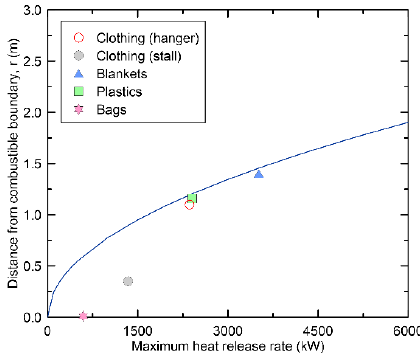
Figure 11. Correlation of separation distance according to maximum heat release rate.